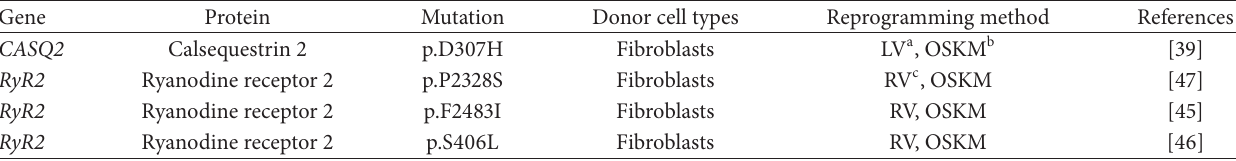
Table 4: Human IPSC-derived patient-specific CPVT syndrome cell